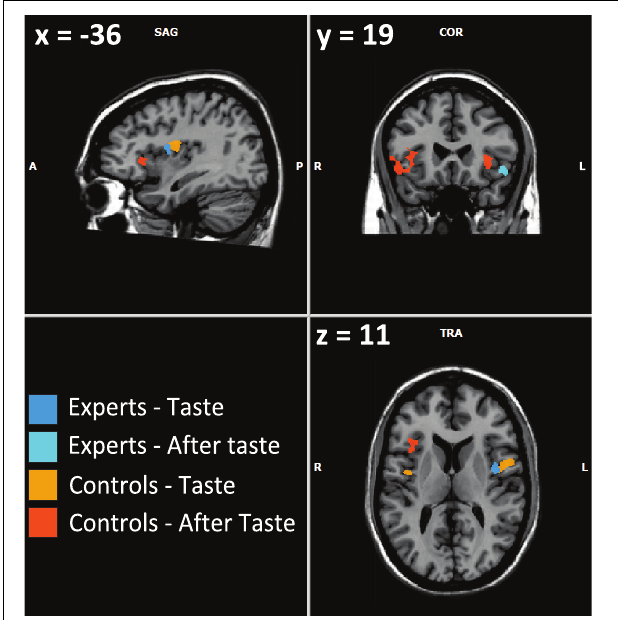
FIGURE 1 | Example of activations involving flavor integration (from Table 2). Visible activations are left pars opercularis and left and right insula for controls during the taste phase, right and left anterior insula and right orbitofrontal cortex for controls during the after-taste phase, left insula for experts during the taste phase, orbitofrontal cortex and the associative occipital cortex for experts during the after-taste